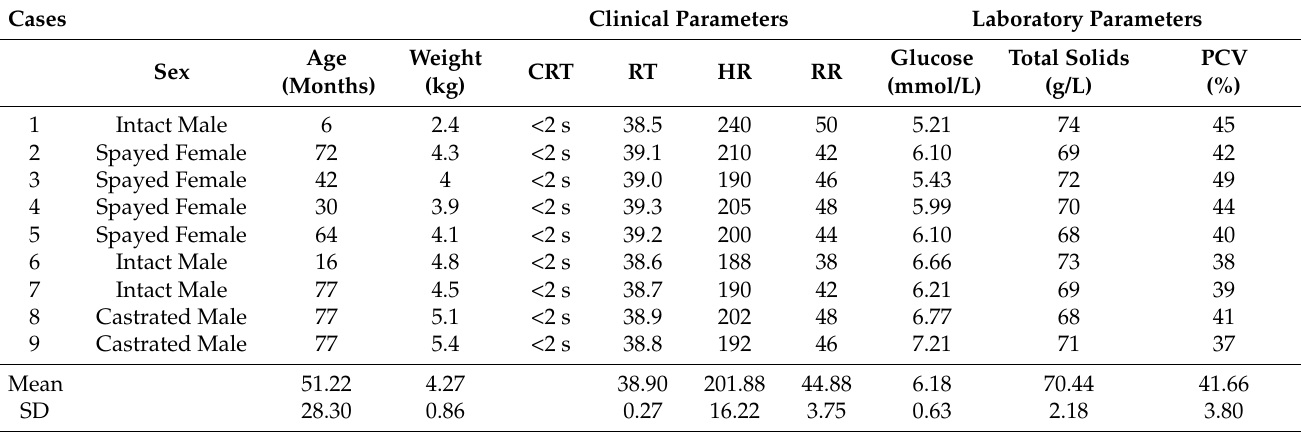
Table 1. Clinical (capillary refill time, CRT; rectal temperature, RT; heart rate, HR; respiratory rate, RR) and laboratory parameters of hospitalized cats at first veterinary